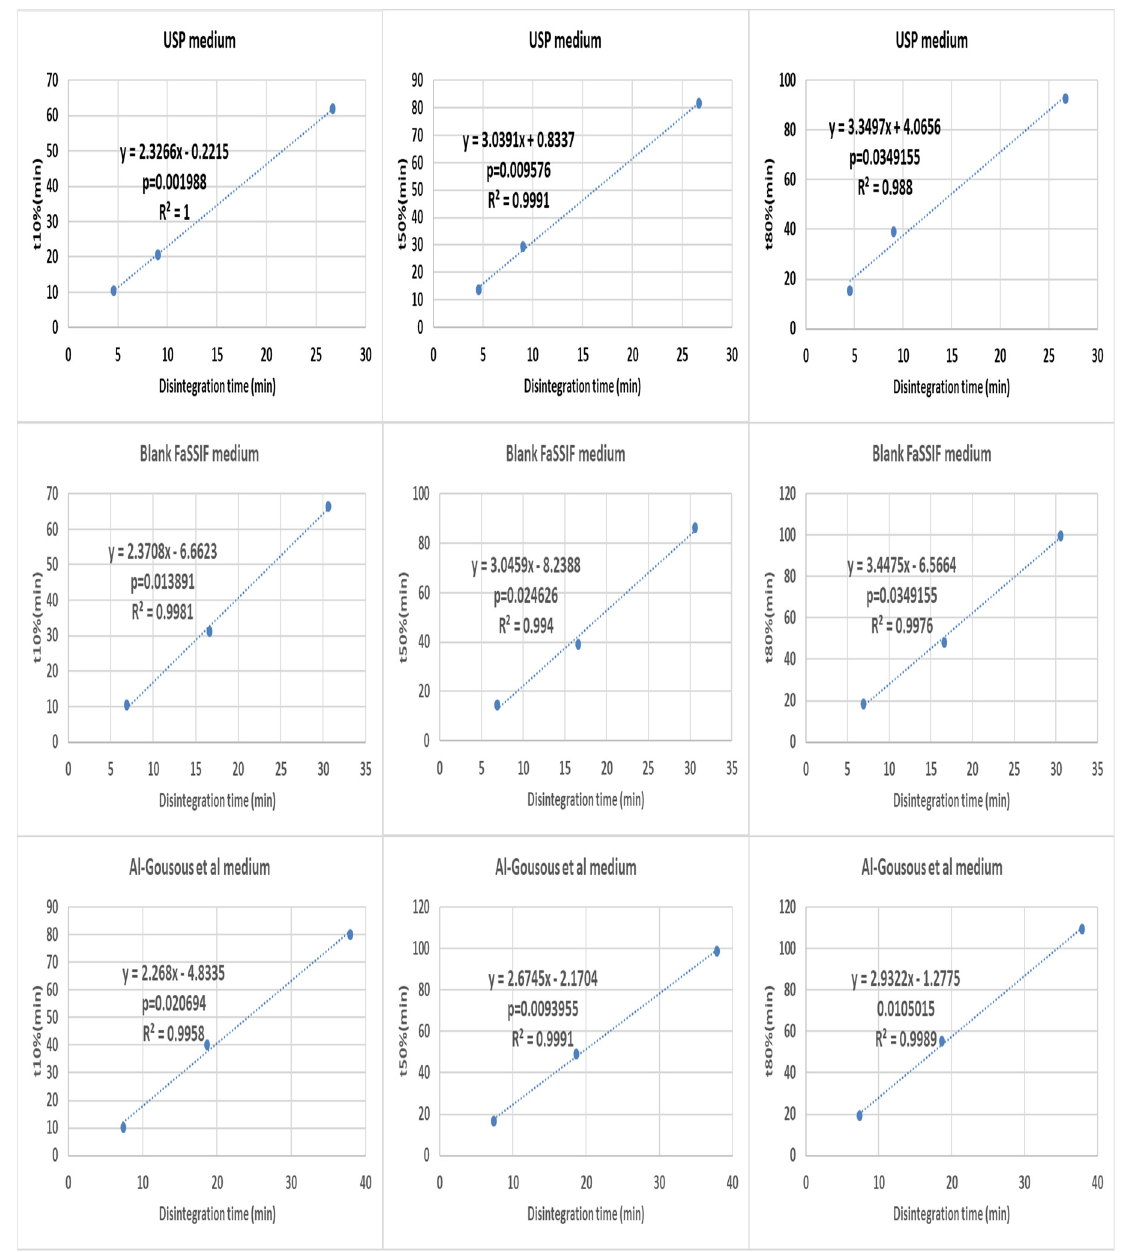
Figure 5. Correlating disintegration times with different dissolution parameters (basket apparatus) for different formulations tested in one medium. The p -value is a one-sided value for a t -test applied to the slope.